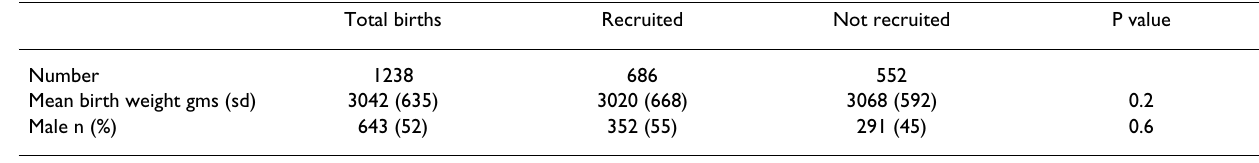
Table 1: Characteristics of those recruited and not recruited at birth. Aboriginal Birth Cohort Study 1987–1990 Total births